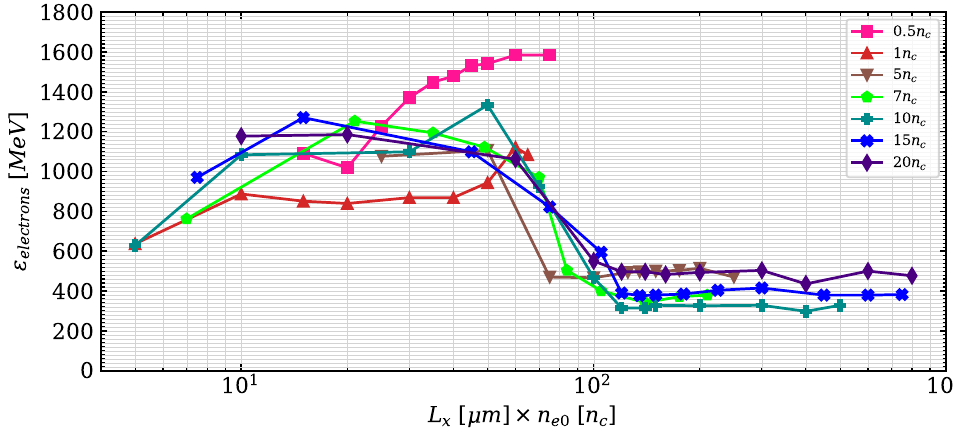
Figure 6. Maximum electron energy vs target areal density, as obtained in 2D PIC simulations. Target parameters: L y = 30 µ m. Laser parameters: λ = 1 µ m, a 0 = 85, τ = 20 fs FWHM and w 0 = 12.5 µ